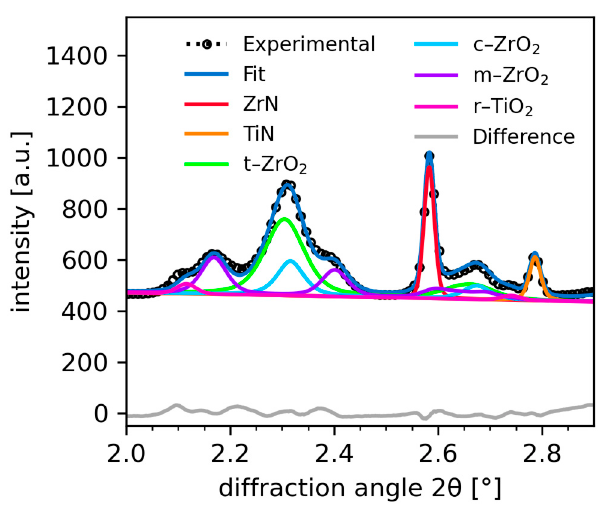
Figure 4. Rietveld refinement of the ZrN sample at 577 ◦ C. The fits of the nitride and oxide phases, as well as the measured pattern, the fit and the difference curve between the measured pattern and the fit are displayed in different